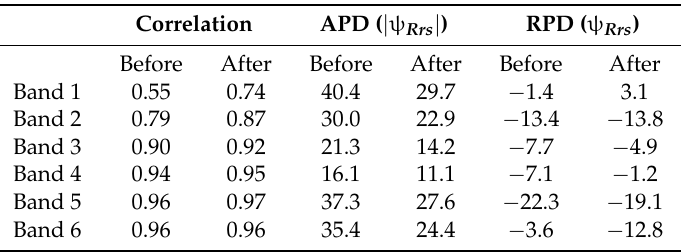
Table 2. Match-up validation results between in situ and GOCI data before and after the CIDUM correction for the six visible bands.